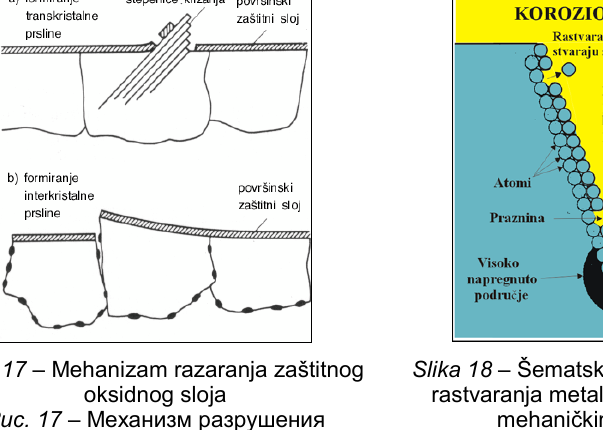
Figure 17 – The mechanism of destruction of the protective oxide layer